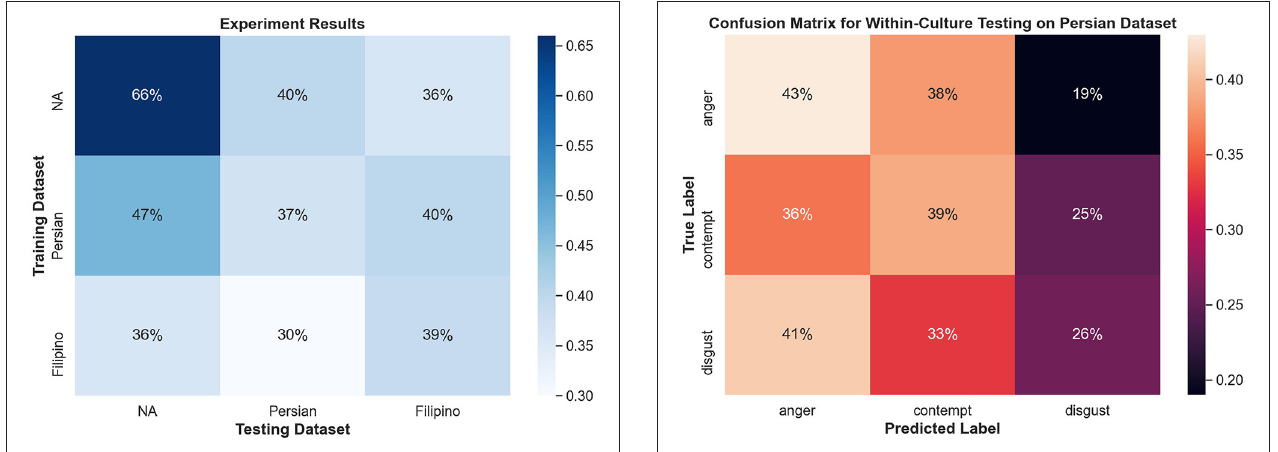
FIGURE 10 | Confusion matrix illustrating the results of the within-culture experiment on the Persian data set.